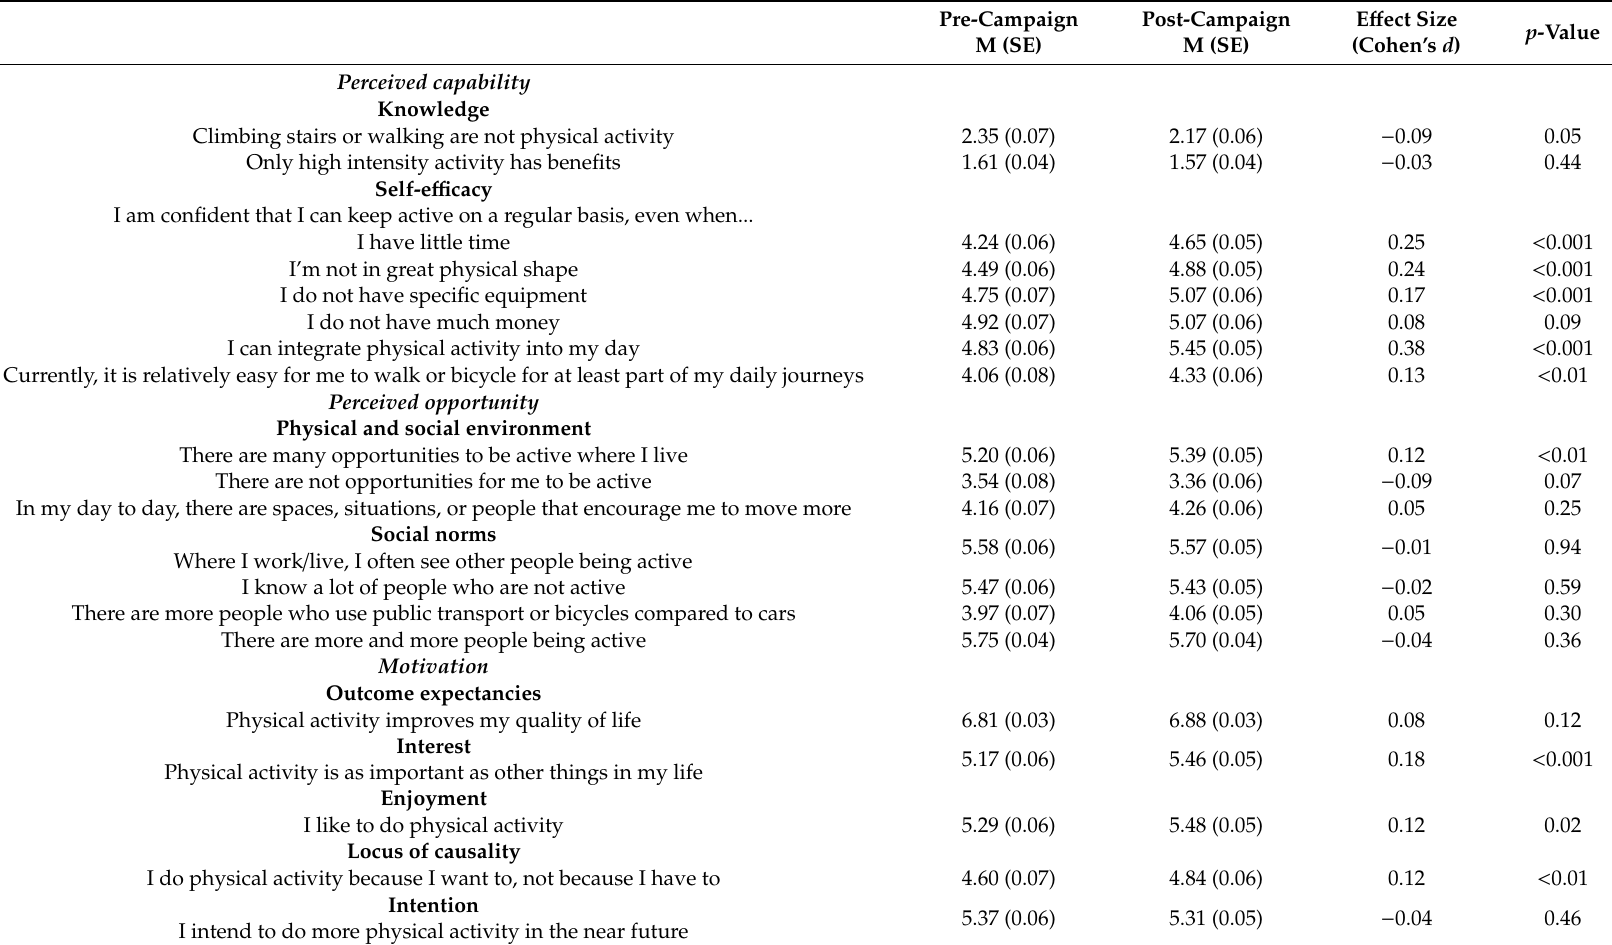
Table 3. Adjusted COM-B proximal indicators for all respondents’ pre-campaign and post-campaign (increasing scores indicate increased agreement).